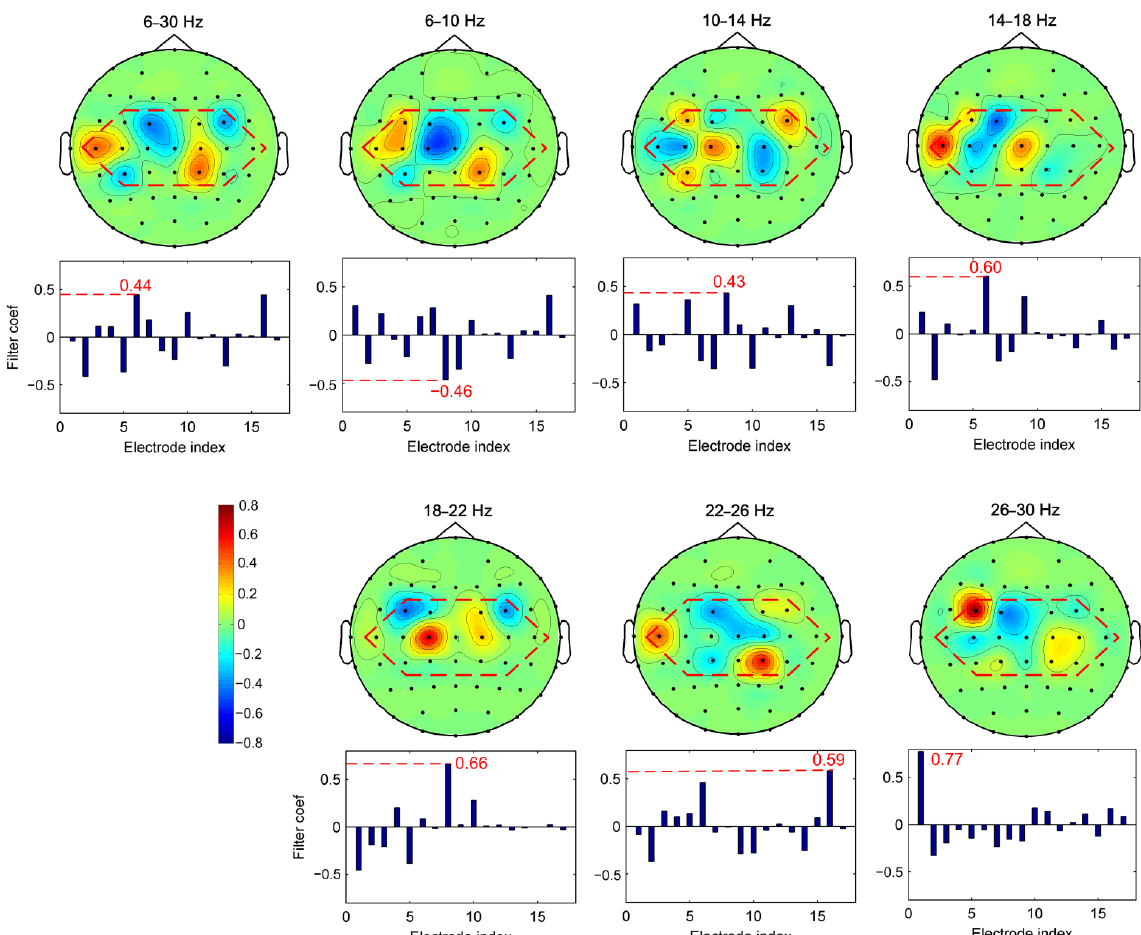
Figure 4. The topographical map and the filter coefficient of the most significant spatial filter learned by the CSP method of each sub-band for subject av. The electrode indexes 1, 2, … , 17 correspond to the electrode FC3, FC1, FCz, FC2, FC4, C5, C3, C1, Cz, C2, C4, C6, CP3, CP1, CPz, CP2, CP4, respectively. Electrodes inside the red outline represent the electrode indexes 1, 2, … , 17 .